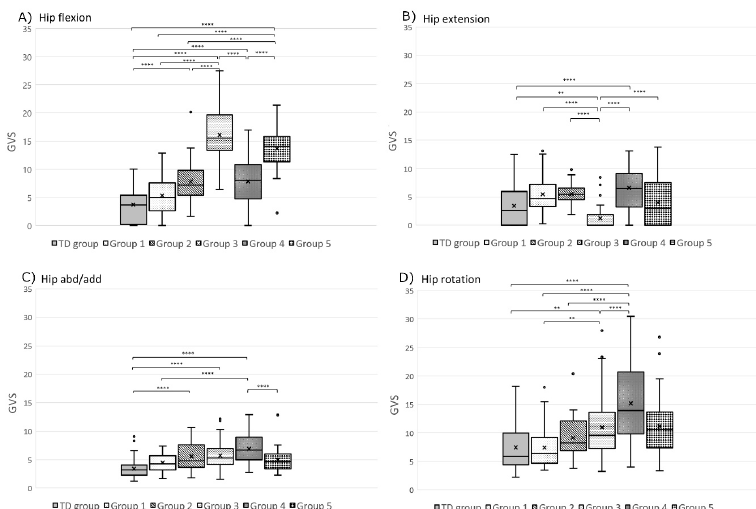
Figure 5. Box plot representation of the gait variable score (GVS) distribution at the hip ( A ) flexion, ( B ) extension, ( C ) abd/adduction, and ( D ) int/ext rotation for each group. In the box plots, the boundary of the box closest to zero indicates the 25th percentile, a black line within the box marks the median, the cross inside the box marks the mean, and the boundary of the box farthest from zero indicates the 75th percentile. Whiskers above and below the box indicate the 10th and 90th percentiles. Points above and below the whiskers indicate outliers outside the 10th and 90th percentiles. TD group: typically developing children (control group). Statistical differences between groups are noted with **** p < 0.0001, ** p < 0.01. J. Clin. Med. 2020 , 9 , x FOR PEER REVIEW